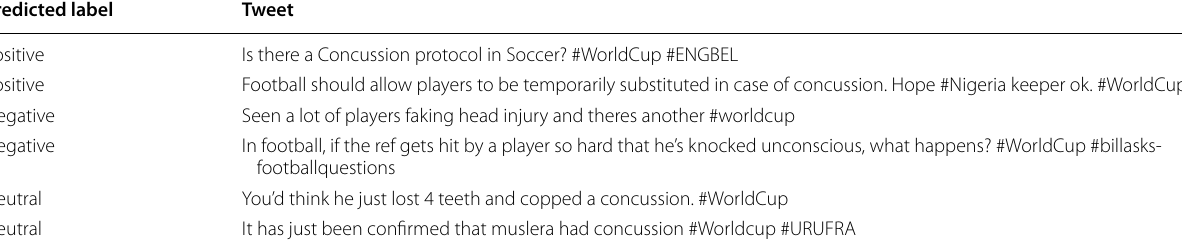
Table 8 Sample Predictions for FIFA World Cup 2018 Predicted label